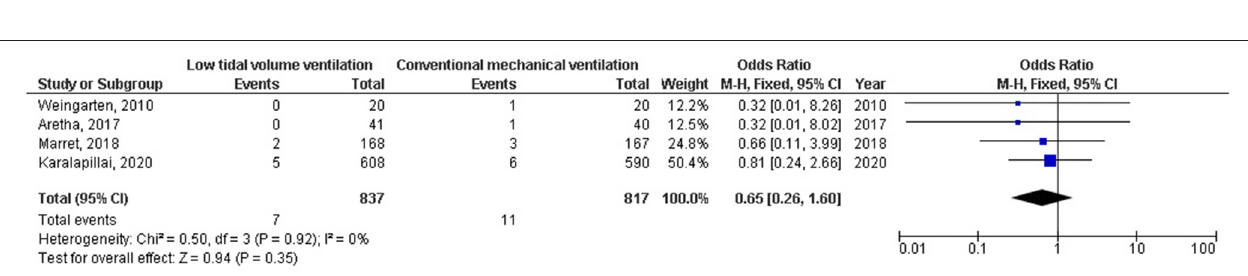
FIGURE 11 | Forest plot of the low tidal volumes strategy vs. conventional mechanical ventilation in subjects undergoing surgery on pulmonary embolism.